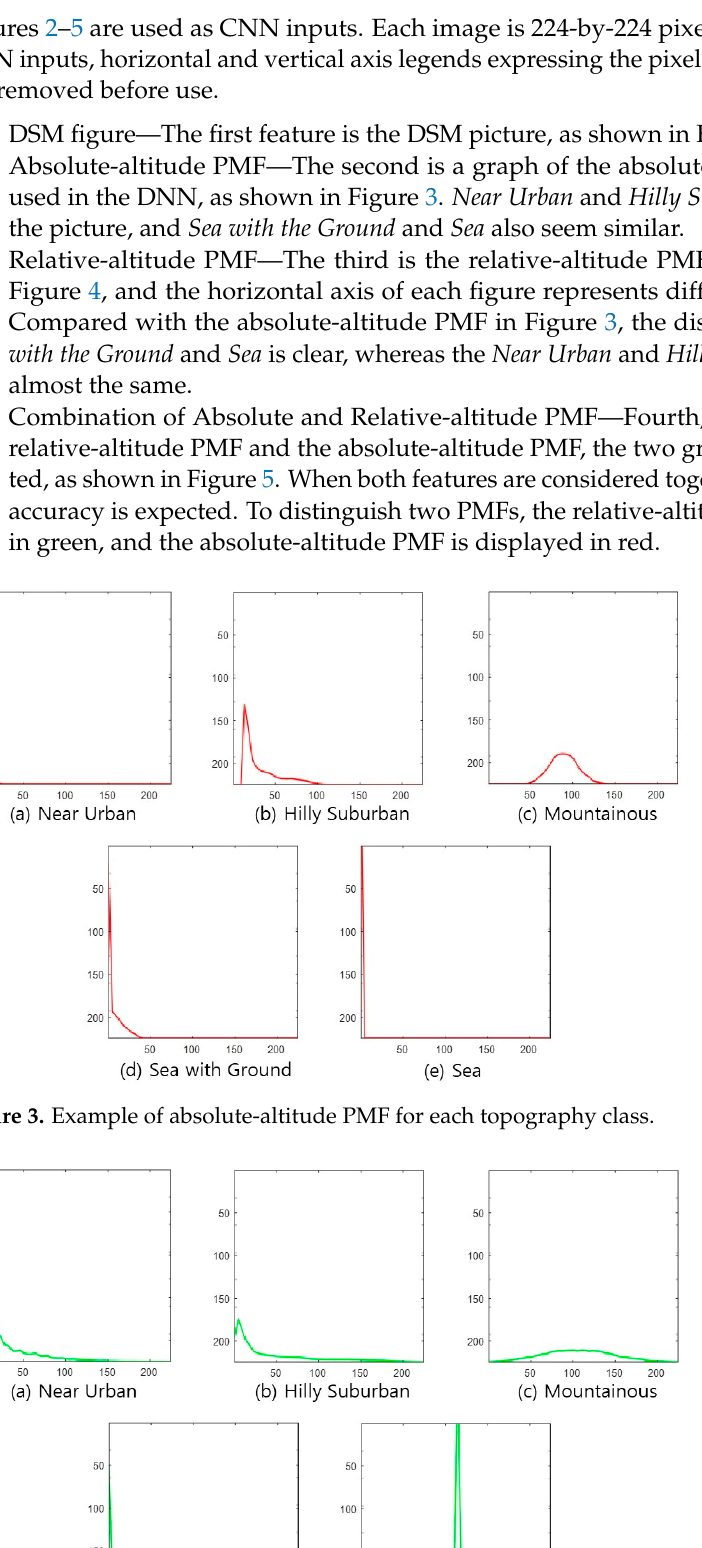
Figure 5. Example of a combination of absolute and relative-altitude PMF for each topography class. 4. Proposed ML Models In this paper, we applied various machine learning methods using the input signals for DNN and CNN presented in Section 2. The machine learning structure, DNN, and CNN implementation methods will be explained in this section, and the performance evaluation results will be presented in the next section. 4.1. Structure of the Proposed ML-Based Automatic Topography Class Classifier In this paper, as shown in Figure 6, we implement two types of learning classifiers and evaluate the classification performance. Figure 6-(a)'s structure is the same as a gen- eral ML-based classifier, where one training model is created and determined as one of all candidates for classification. All candidate classes may be classified well with the one-step classifier structure shown in Figure 6-(a), but there may be situations in which detection errors occur significantly between specific classes. Although detailed simulation results will be presented in Section 5, in the case of the five topographic classification problems